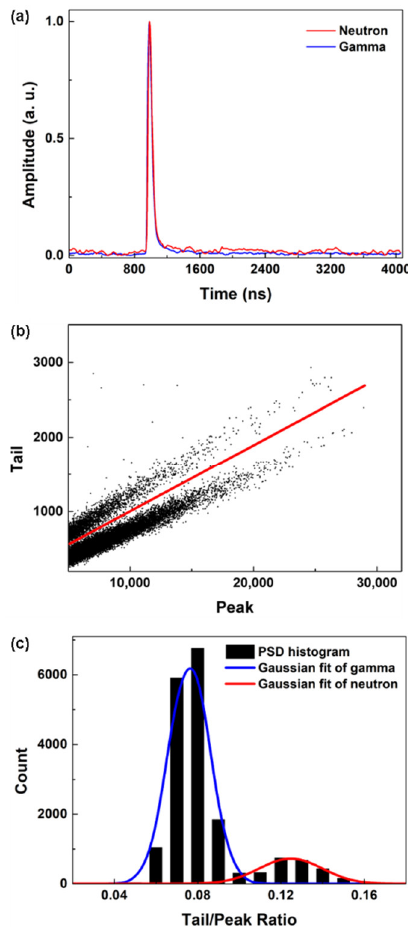
Figure 6. Signals detected with the neutron detector. ( a ) Pulse light detected from the neutron de- tector modules. ( b ) PSD scatter plot with a PSD threshold (red line). ( c ) PSD histogram with Gauss- ian fitting plots.